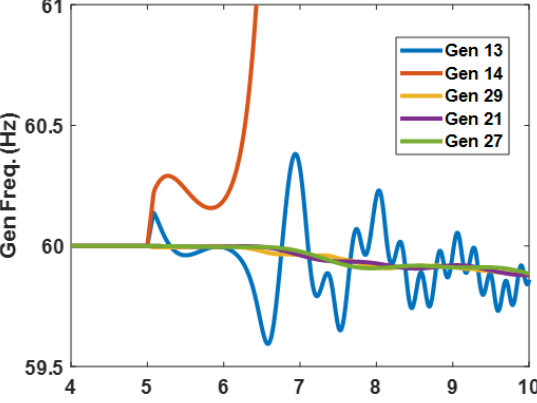
Figure 17. Speed of selected generators in the WNAPS.